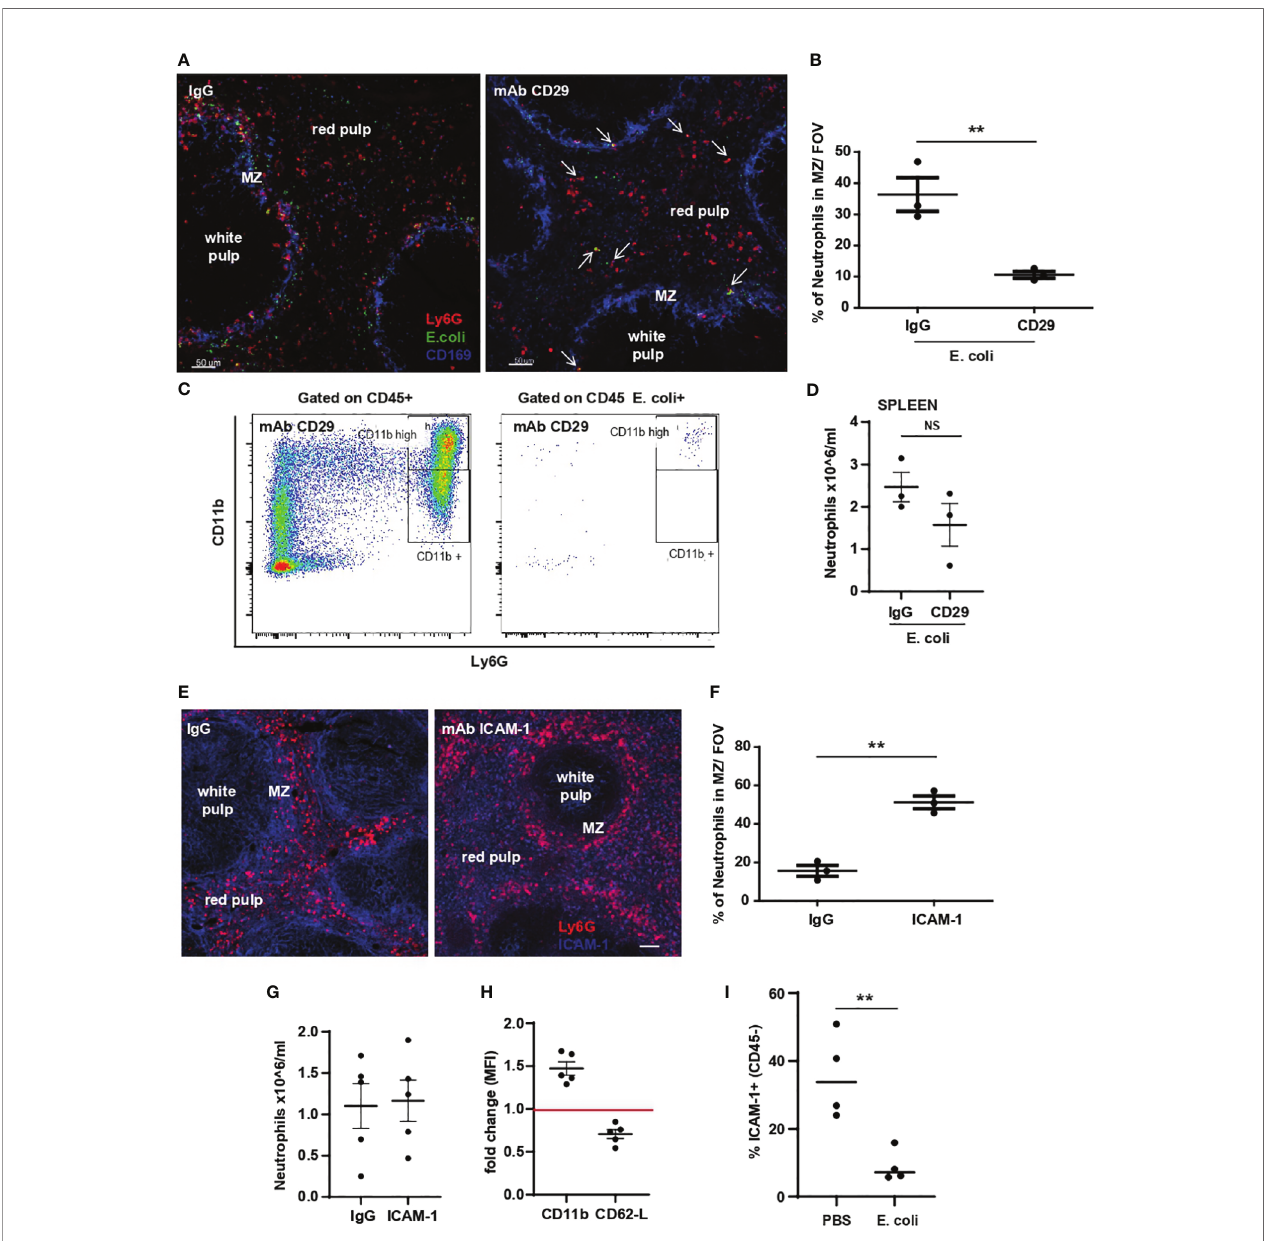
FIGURE 7 | CD11b-, CD29-integrin and ICAM-1 role in splenic neutrophil retention, relocation, and clustering. (A) PCSS image of IgG and anti-CD29 mAb pre- treated mice challenged for 60 min with systemic E. coli . Scale bar 50 m m. Arrows point to some neutrophils that co-localize with E. coli after anti-CD29 mAb treatment (B) % of splenic neutrophils in the MZ/FOV counted in PCSS of IgG and anti-CD29 mAb pre-treated mice challenged for 60 min with systemic E. coli , unpaired t-test , (N=3 mice/group). (C) Flow cytometry analysis of E coli -positive splenic neutrophils pre-treatment with CD29 mAb. (D) Quanti fi cation of splenic neutrophils 60 min after i.v. injection of E. coli pre-treated with anti-CD29 mAb, two independent experiments (N=3 mice/treatment). (E) PCSS image of IgG or anti- ICAM-1 mAb treated mice. Scale bar 50 m m. (F) % of splenic neutrophils located in the MZ/FOV counted in PCSS after IgG or ICAM-1 mAb for 60 min, unpaired t- test , (N=3 mice/group). (G) Quanti fi cation of splenic neutrophils from mice treated for 60 min with i.v. IgG or ICAM-1 mAb, two independent experiments (N=5 mice/ treatment). (H) MFI of anti-CD11b and anti-CD62L mAb of splenic neutrophils after anti-ICAM-1 mAb or IgG treatment expressed as fold change. (I) % of ICAM-1 expressed by CD45- splenocytes 60 min after i.v. injection of PBS or E. coli , representative of three experiments, unpaired t-test, (N=4 mice/treatment). P < 0.01 **, NS, non signi fi